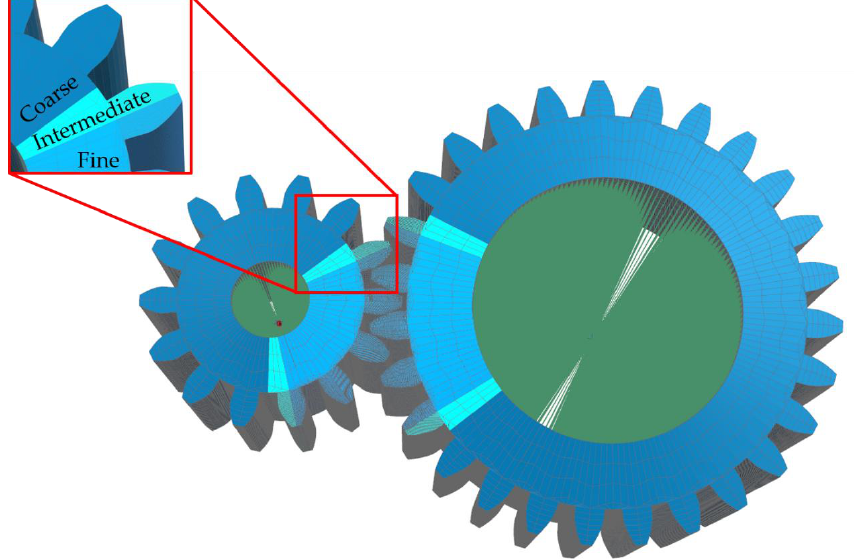
Figure 5. The finite element model of the analyzed straight bevel gear pair.